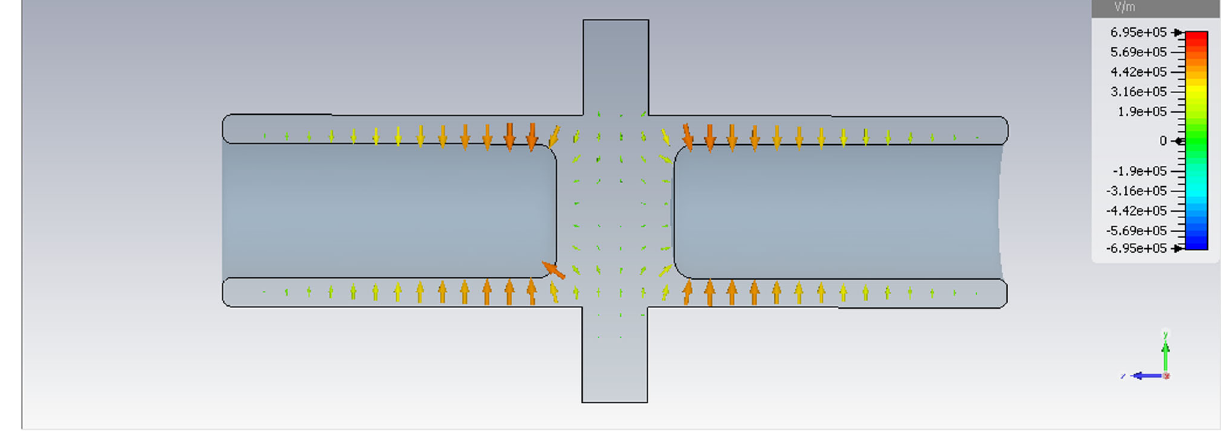
FIG. 46. A symmetric cavity with no transverse kick with its electric